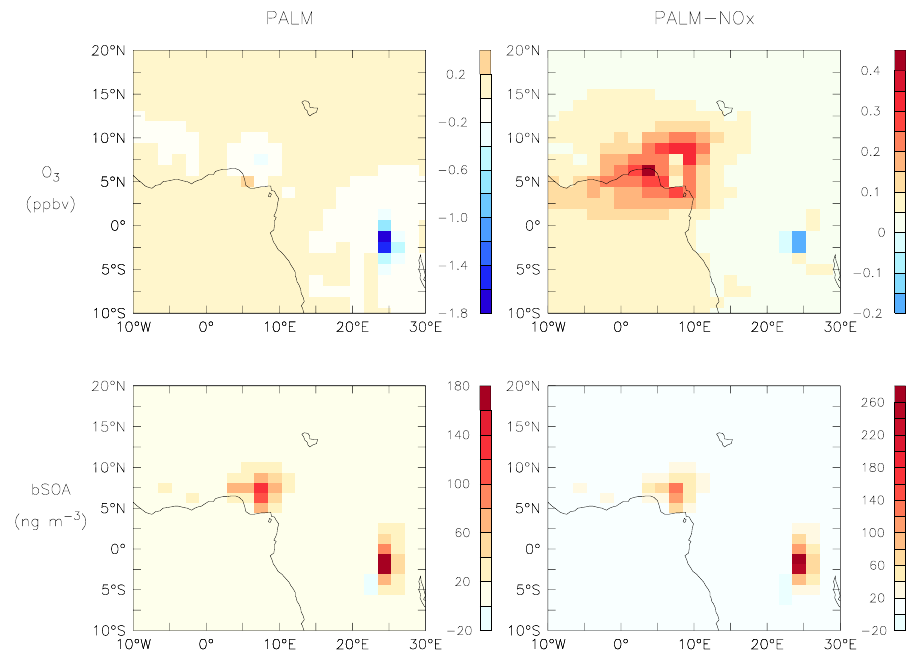
Fig. 3. Differences in annual mean surface concentratmbo emissionsions of ozone (top) and SOA (bottom) for Africa for PALM vs. CTRL. (left) and PALM NO x vs. CTRL (right). Note change of scale from PALM to PALM NO x .